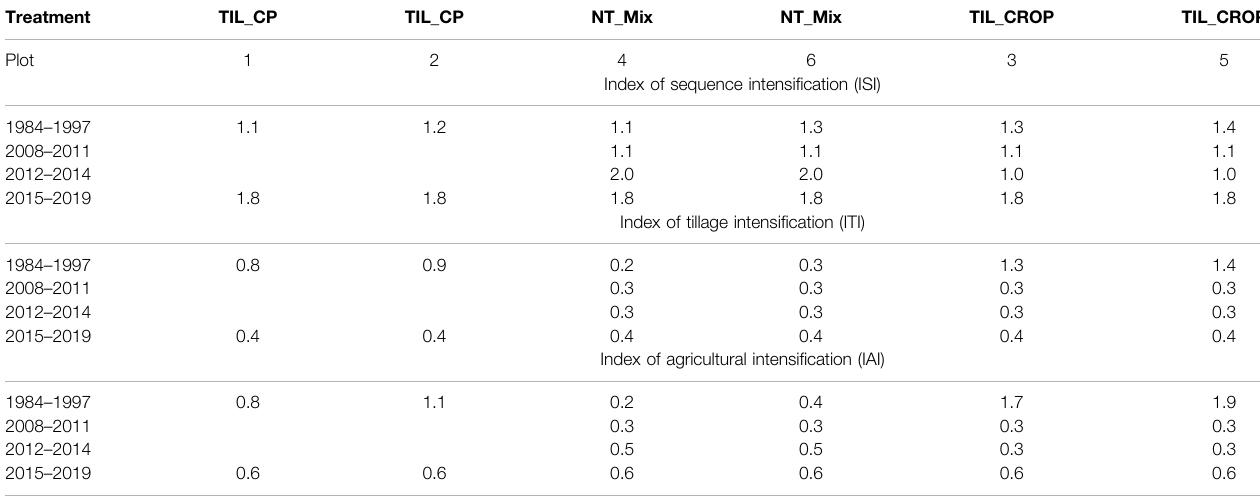
TABLE 2 | Land use history expressed as index of agricultural intensi fi cation per plot and experimental period (ISI: index of sequence intensi fi cation, ITI: index of tillage intensi fi cation, IAI: index of agricultural intensi fi cation). Treatment